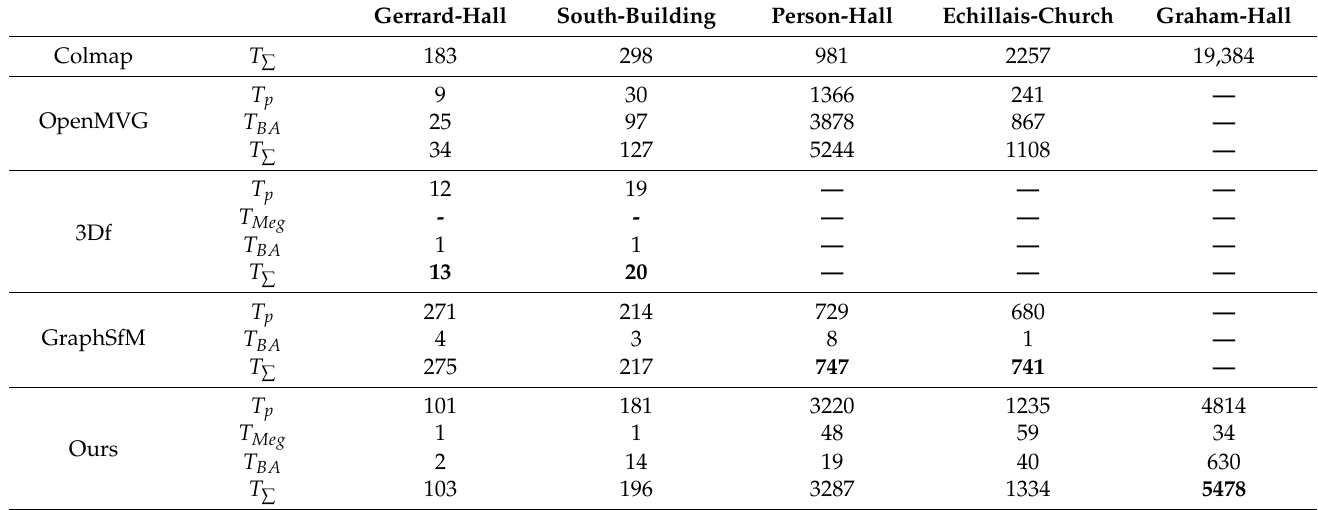
Table 7. Public dataset efficiency statistics. ( T p : local reconstruction time; T Meg : subcluster merging time; T BA : global bundle adjustment time; T ∑ : total time. - represents no merging operation, such as with 3Df where scene partitioning is not performed with less than 1000 images, and time is no longer counted; — represents failure, time unit: seconds).